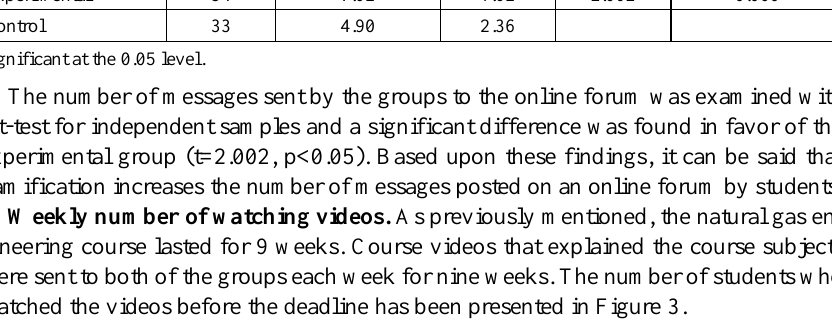
Table 7. Descriptive and t-test findings regarding messages posted Group